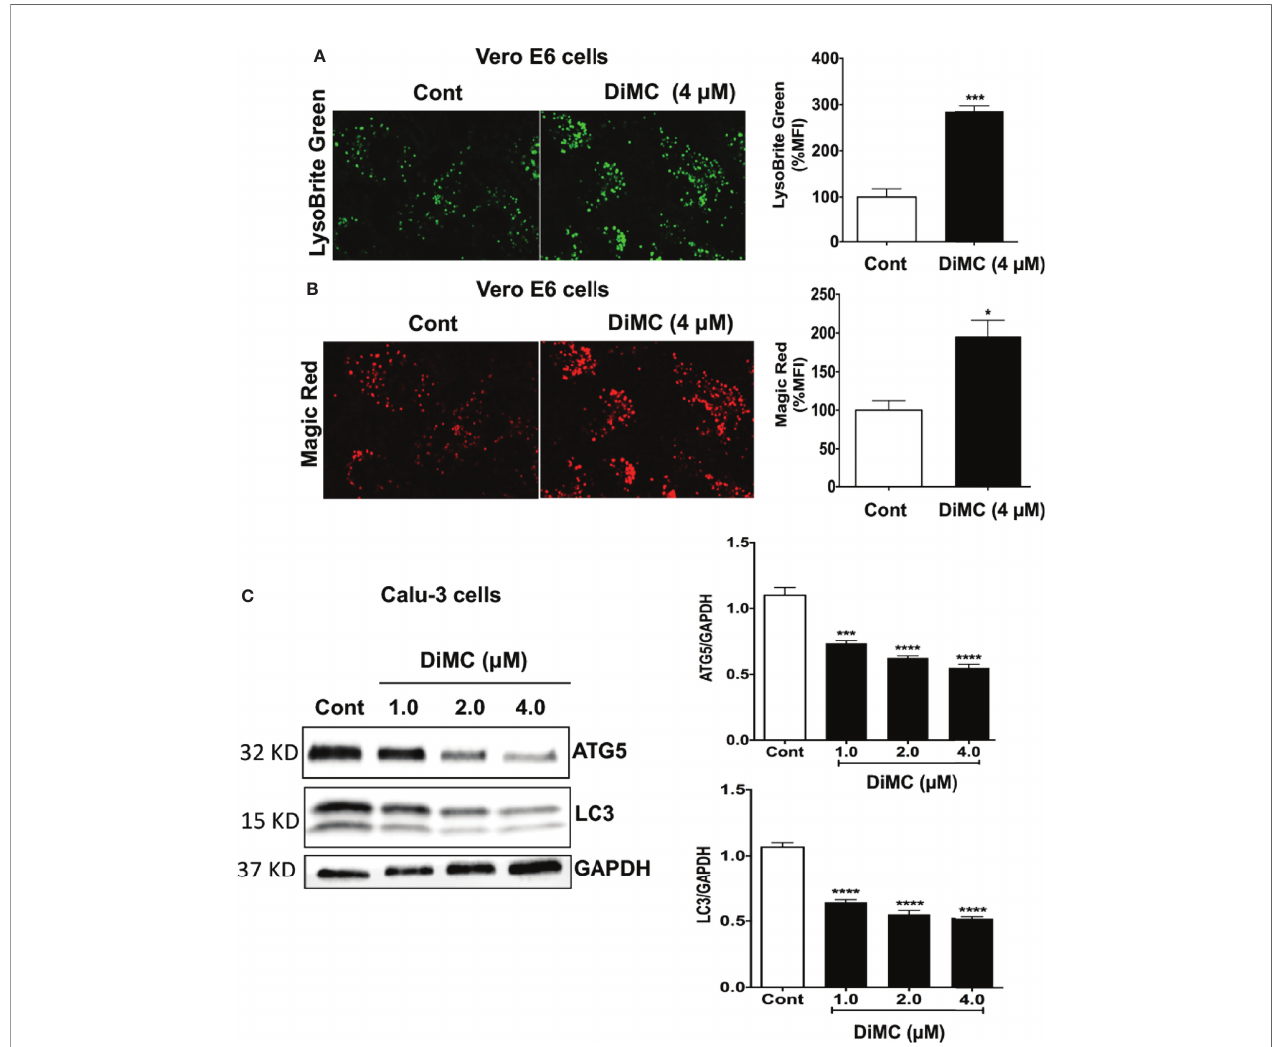
FIGURE 3 | DiMC increased endolysosome acidi fi cation, increased cathepsin B activity and decreased autophagy: (A) Endolysosome pH was estimated by a pH sensitive LysoBrite green dye in Vero E6 cells. DiMC (4 m M for 18 h) increased fl uorescence intensity of LysoBrite (n = 3, *p<0.05); increases in fl uorescence intensity indicates decreases (acidi fi cation) in endolysosome pH. (B) DiMC (4 m M for 18 h) signi fi cantly enhanced the activity of cathepsin B as indicated by increased mean fl uorescence intensity of Magic Red in Vero E6 cells. (n = 3, ***p <0.001). (C) DiMC (1.0, 2.0, and 4.0 µM for 18 h) signi fi cantly decreased protein expression levels of the autophagy markers ATG5 and LC3B in Calu-3 cells (n = 3, ***p <0.001, ****p